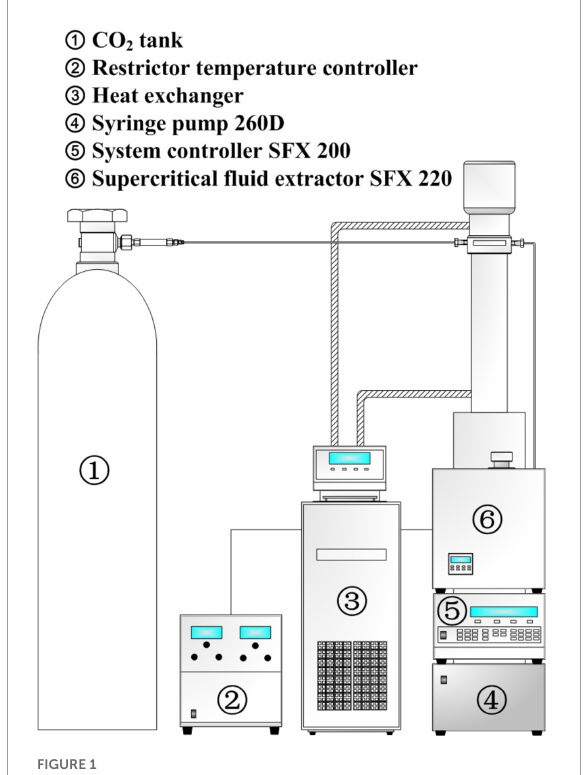
FIGURE1 Schematic diagram of supercritical carbon dioxide extraction